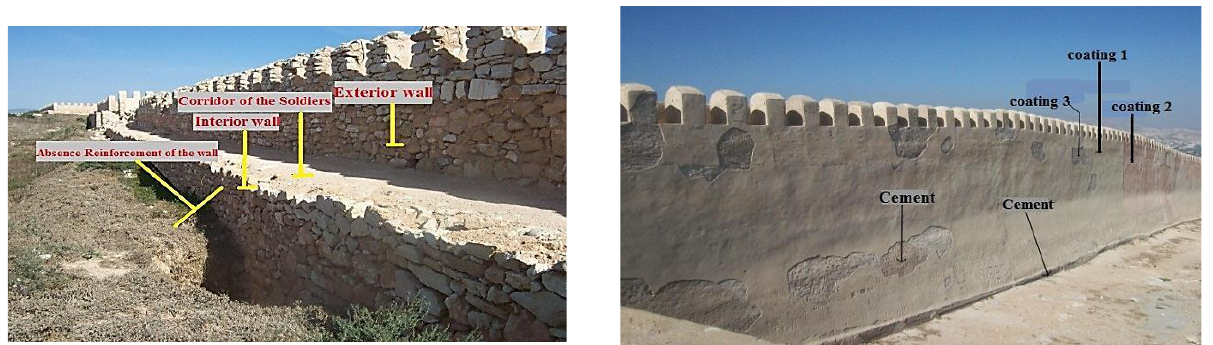
Figure 5. The wall coating damaged due to the mismatch of the components of the